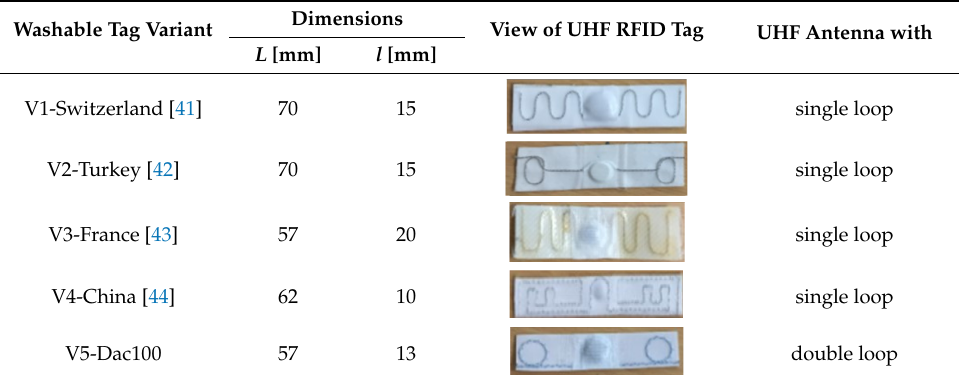
Table 5. Description of UHF RFID tag variants.